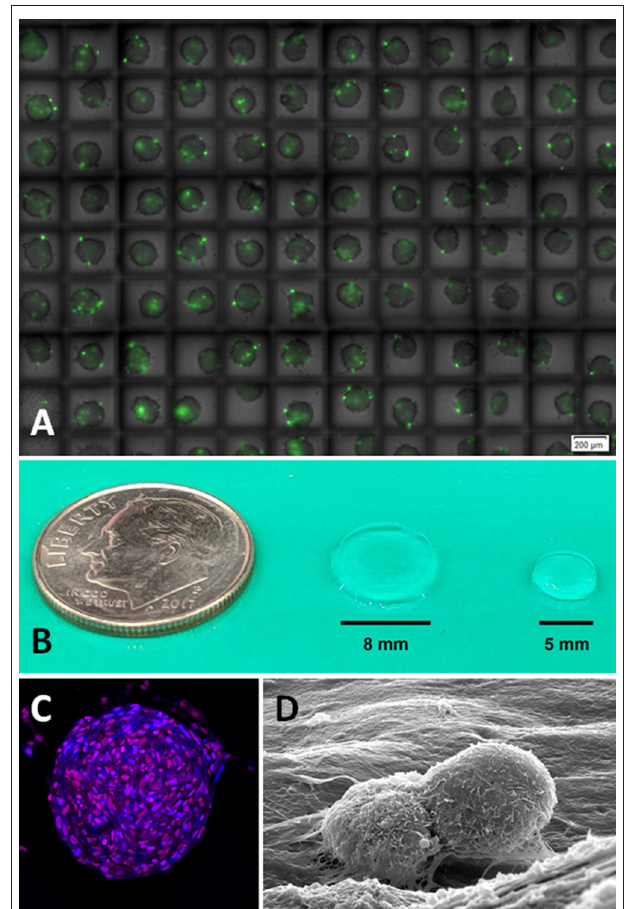
FIGURE 4 | (A) Glioblastoma spheroids in high throughput high-density hanging drop culture on a microchip. Method allows for the rapid screening of novel therapeutic agents in cancer cells growing in 3D whereby diffusional gradients and cell-cell interactions are more accurately recapitulated than 2D cell culture conditions (monolayer). Green dye (Celltox TM Promega) shows cell death after 24h of culture (Image courtesy of Anurup Ganguli and Rashid Bashir, UIUC). (B) Relative size of hydrogel scaffolds for the study of (C) 3D glioblastoma spheroids by confocal fluorescent microscopy and associated (D) homotypic (cell-cell) and heterotypic (cell-ECM) interactions by scanning electron microscopy (Images courtesy of Emily Chen and Brendan Harley, UIUC). UIUC, University of Illinois at